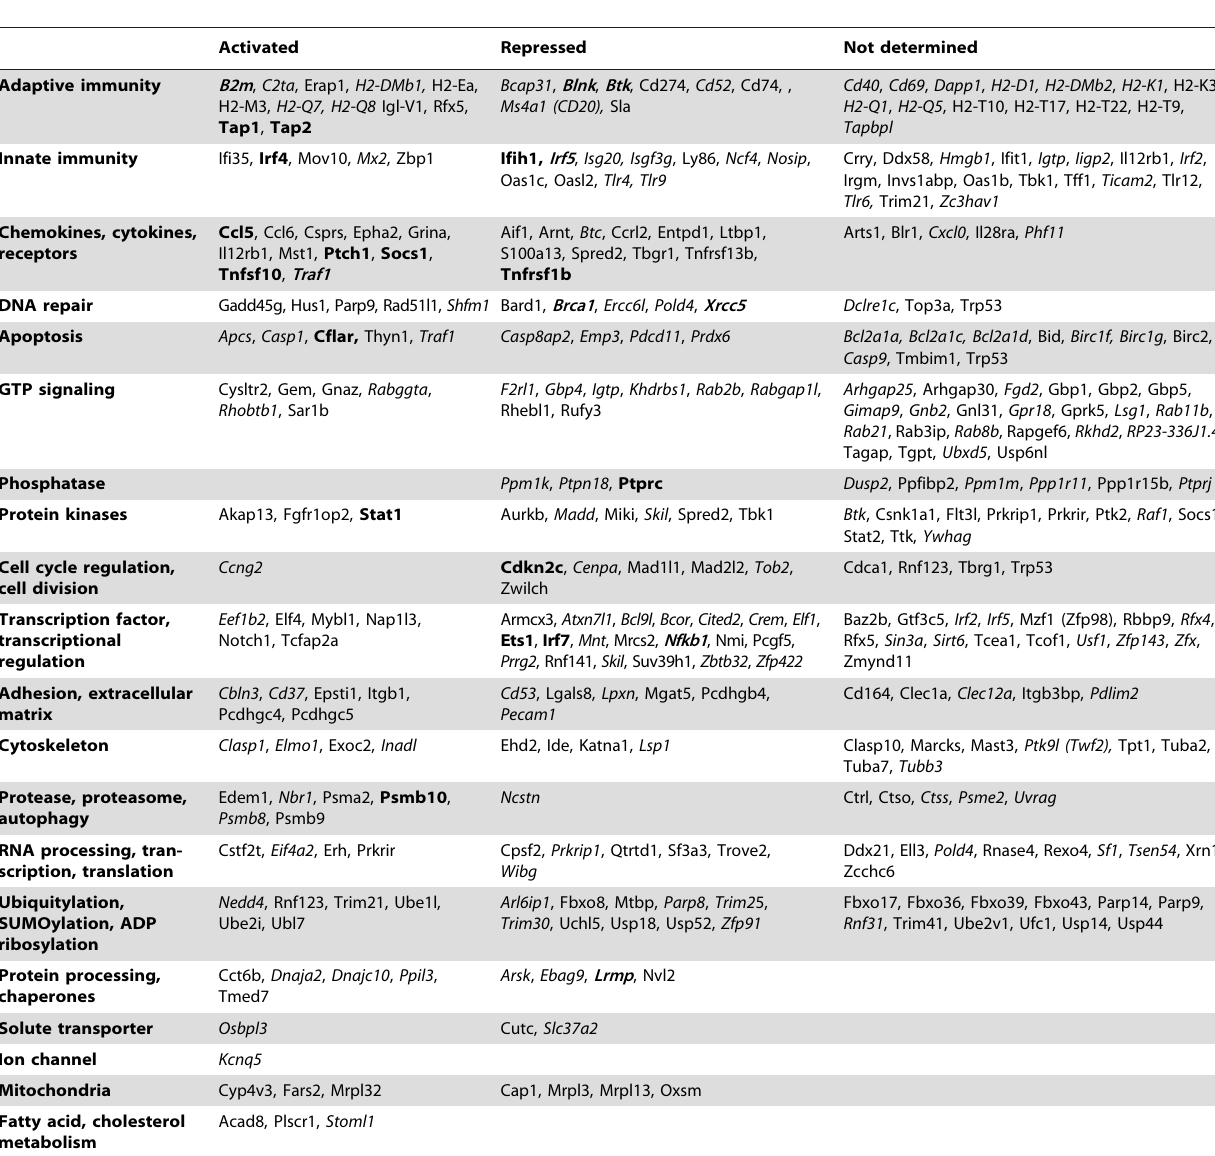
Table 1. Functional and transcriptional features of IRF8 target genes in mouse cell lines of GC B cells.